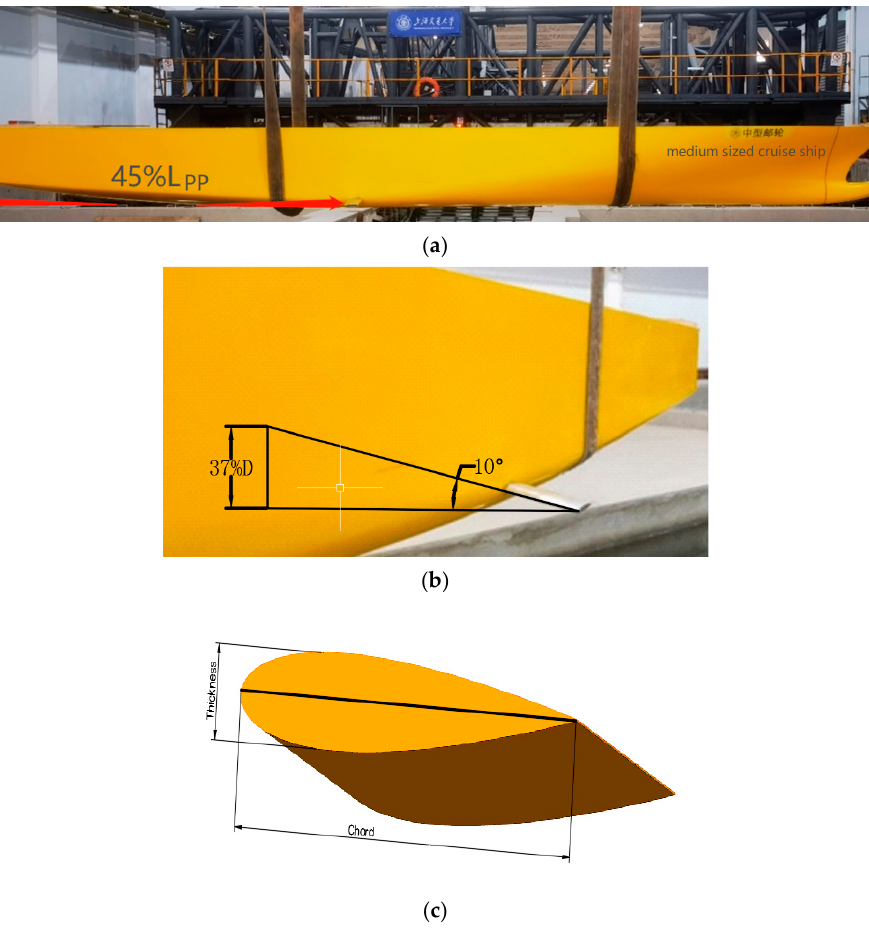
Figure 3. Display of ship model with fins. ( a ) The whole model. ( b ) Fin at port side. ( c ) Hydrofoil section of the fin.